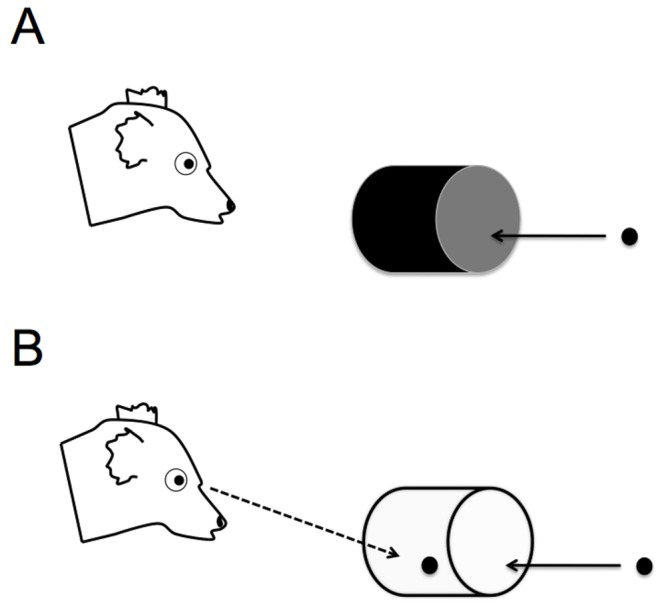
The apparatus for Experiment 2.In warm-up trials (A) the cylinder was opaque, preventing the subject from seeing the food while approaching. In test trials (B) the cylinder was transparent inducing the temptation to approach the visible food directly.